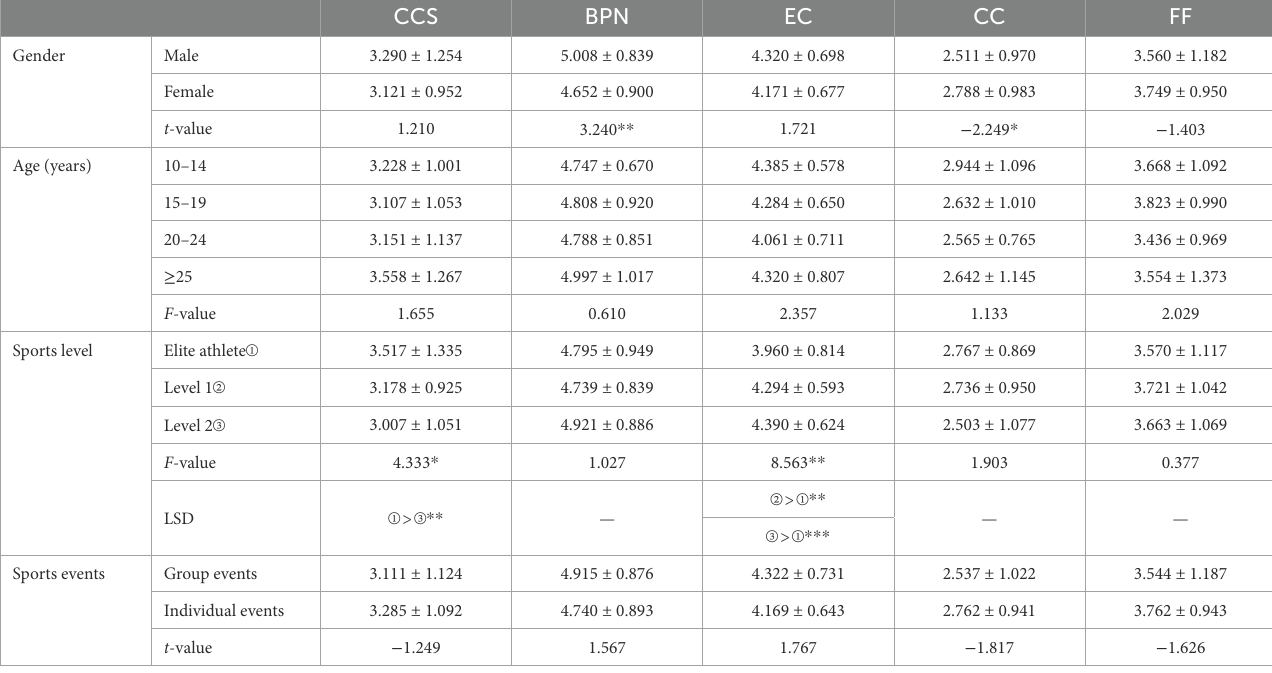
TABLE 2 Comparison of differences in the various variables ( n =